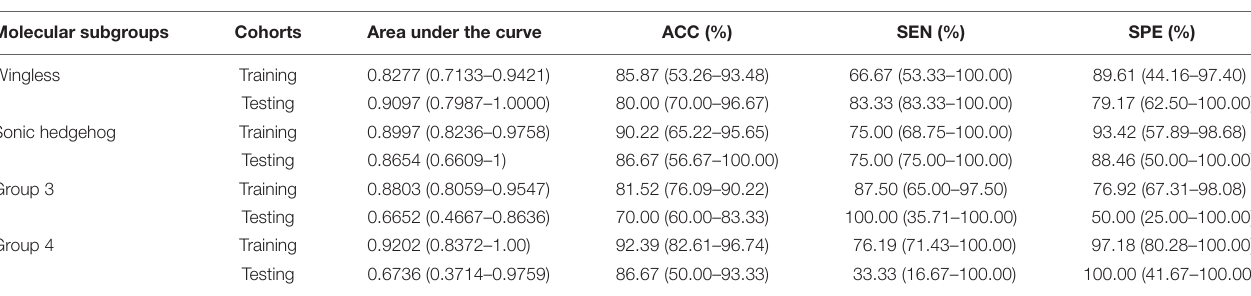
TABLE 4 | Summary of the subgroup-specific classification performance of the RLHC